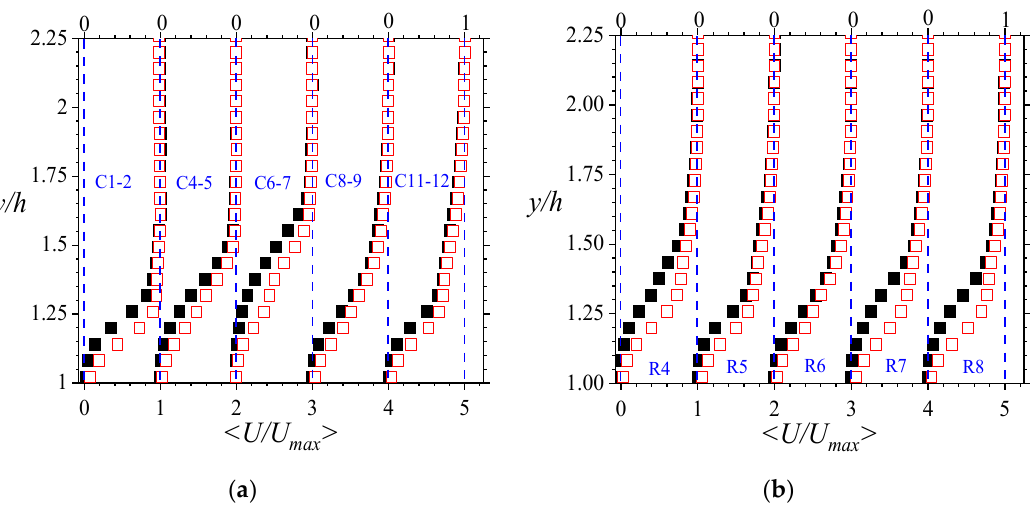
Figure 11. Turbulence quantity < U/U max > is the line-averaged mean streamwise velocity normalized by the maximum local line-averaged streamwise mean velocity in open and porous regions. Here, the profiles for the flow in the open region are shown. Staggered plots in ( a ) show the streamwise variations whereas ( b ) demonstrate the spanwise variations. The denominations C and R respectively stand for columns and rows, and are illustrated in Figure 1. Black-filled boxes are the results for Test A , and red-open boxes are the results for Test B